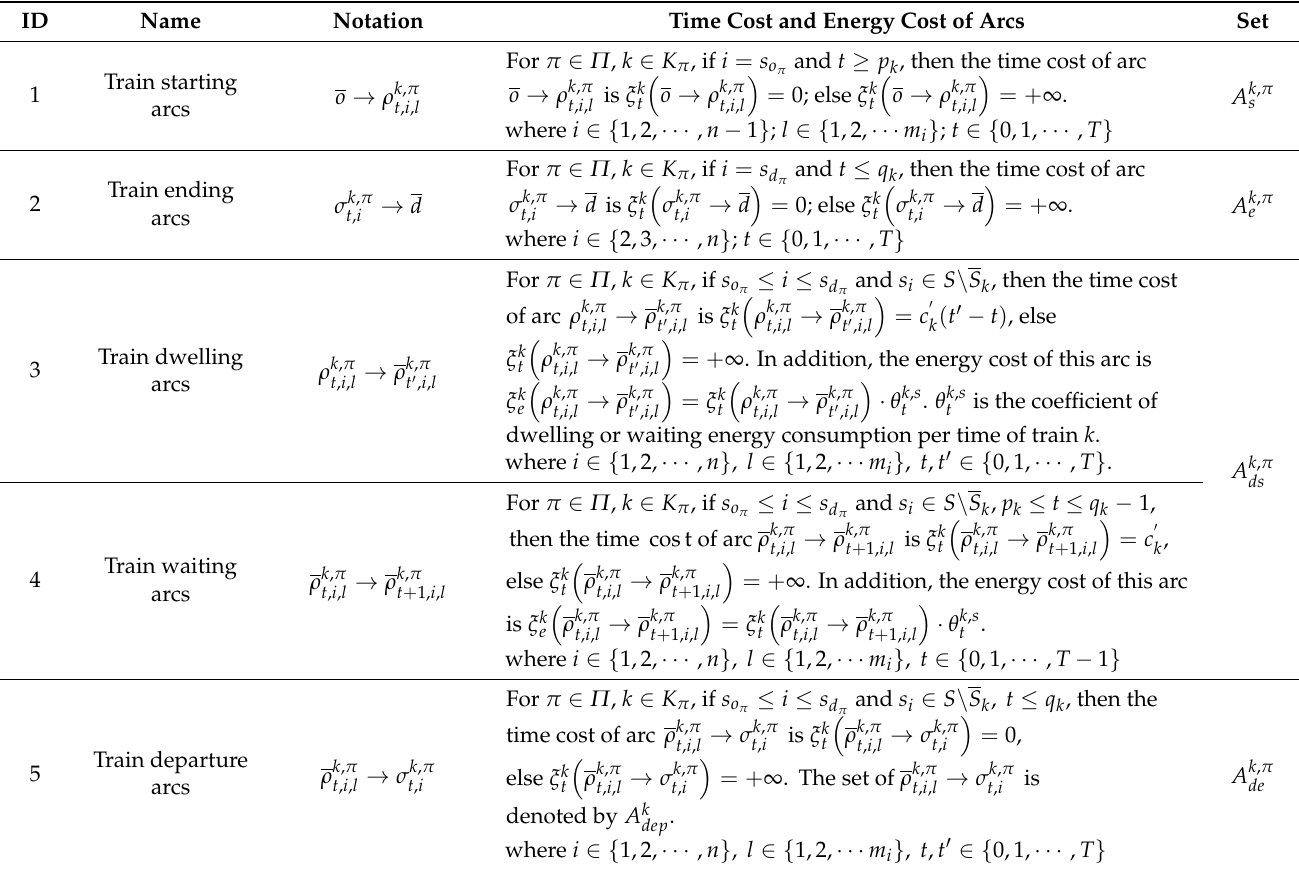
Table 2. The arc set of spatial-temporal